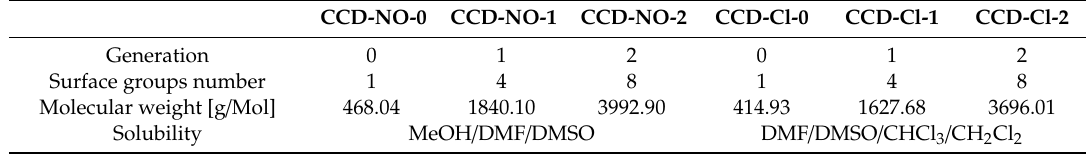
Table 1. Characterisation of copper metallodendrimers with chloride and nitrate surface